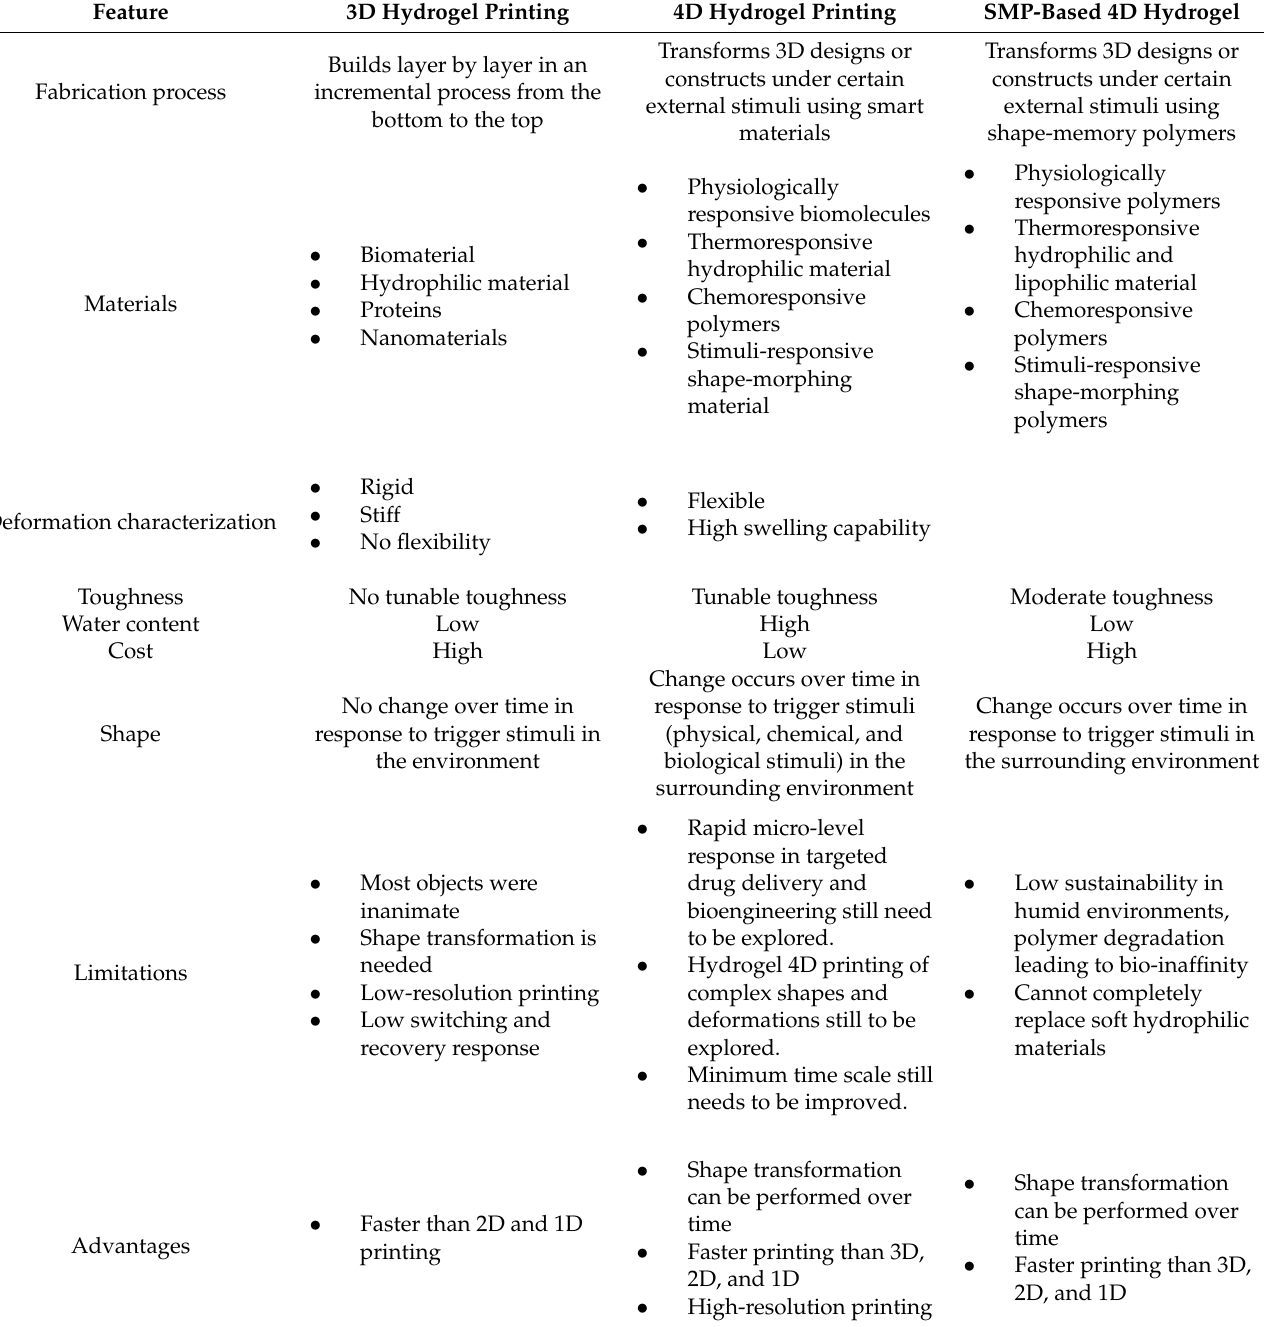
Table 3. 3D hydrogel printing, 4D hydrogel printing, and SMP-based 4D hydrogel